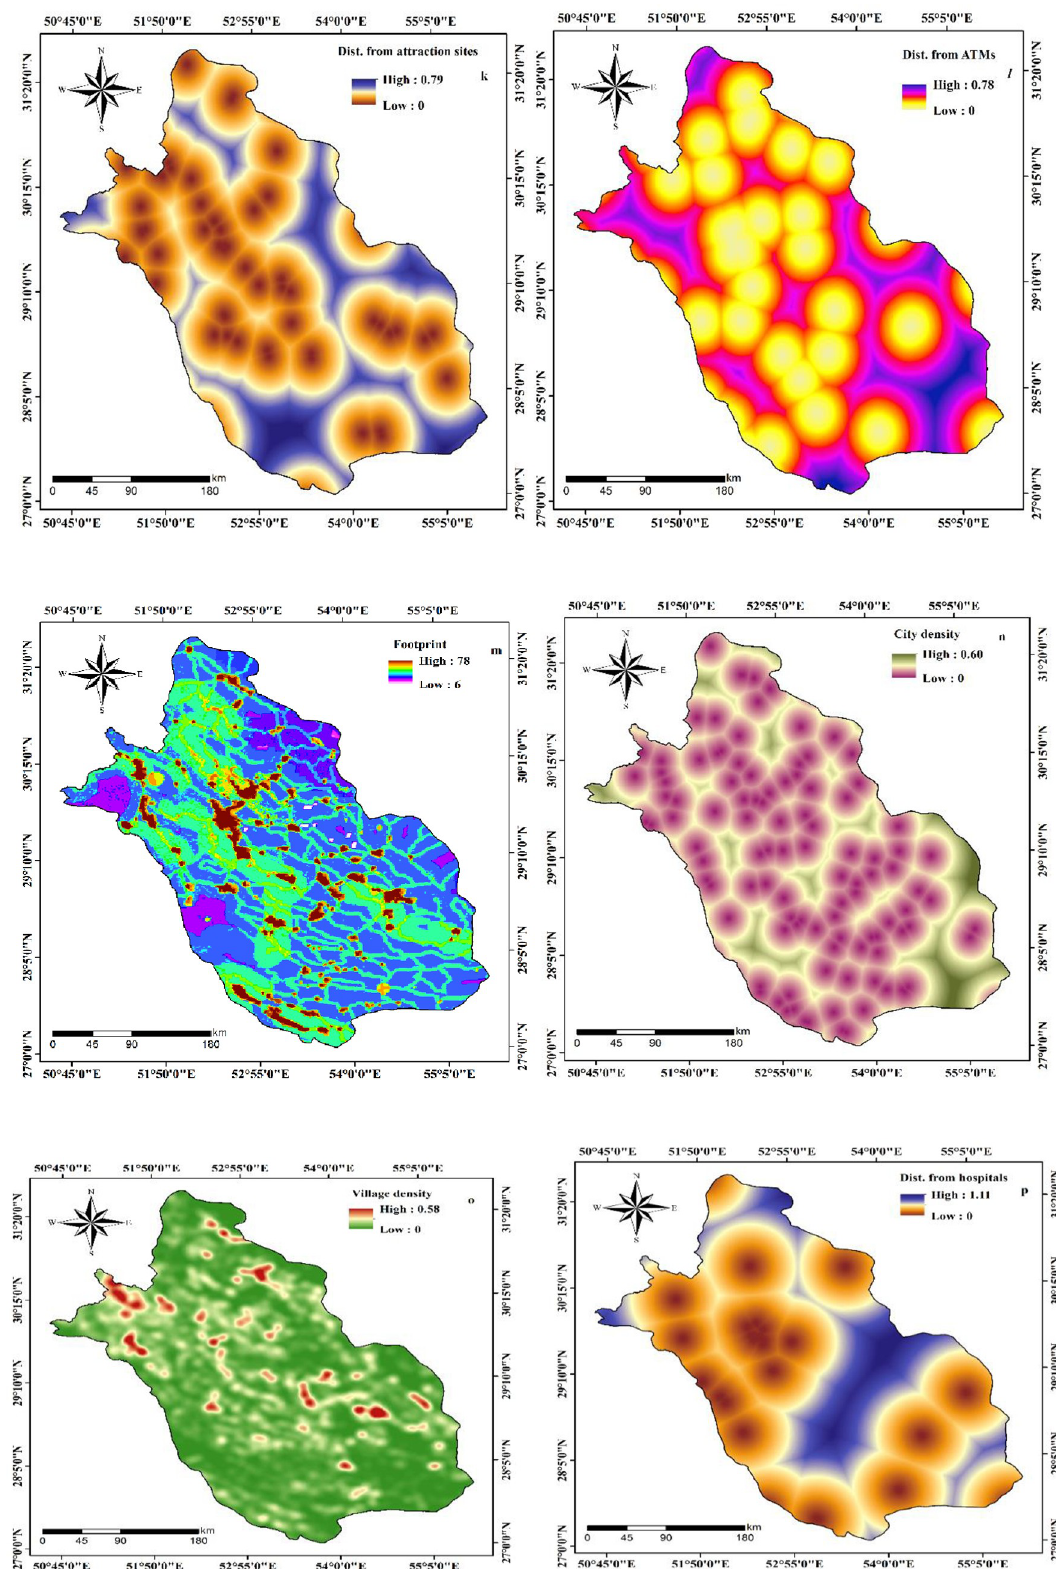
Fig 5. Preparation of effective factors of COVID-19 outbreak. https://doi.org/10.1371/journal.pone.0236238.g005 PLOS ONE | https://doi.org/10.1371/journal.pone.0236238 July 28,